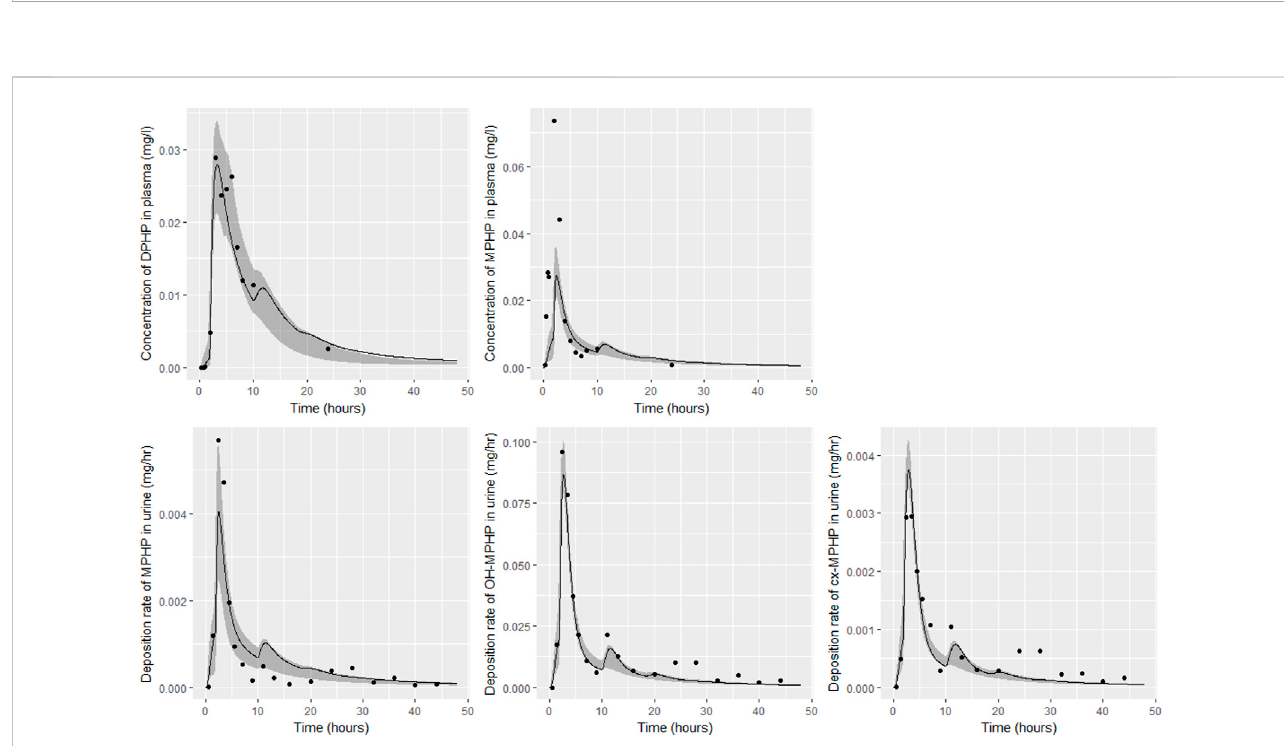
FIGURE 7 Fit ofthe calibrated model to data from individual (B) . Panel (A) DPHP in venous blood (mg/L); (B) MPHP in venous blood (mg/L); (C) rate of depositionof MPHP into the bladder; (D) rate of deposition of OH-MPHP into the bladder; and (E) rate of deposition of cx-MPHP into the bladder. The central estimates indicated in plots correspond to the posterior mode whereas the shaded regions represent 95% intervals for the respective